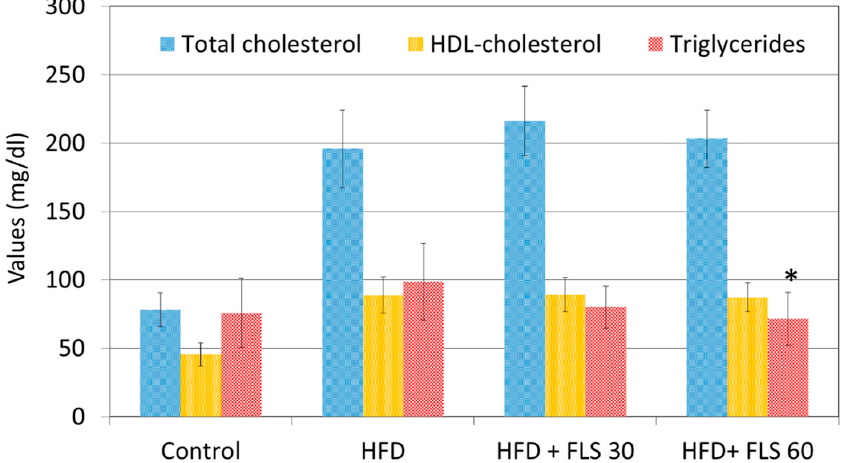
Figure 4. Average total cholesterol, HDL-cholesterol and triglycerides measured in the blood of the mice at the end of the experiment, after 84 days of FLS treatment. Error bars represent the standard error of the mean. FLS at 60 mg/kg significantly reduced the blood triglyceride concentrations to values not statistically different from those measured in the Control group. *, p < 0.05 compared to the HFD group.